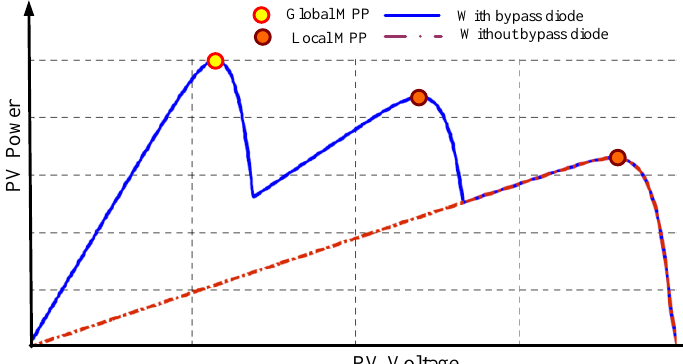
Figure 1. PV (photovoltaic) array power–voltage (P–V) characteristic under partial shading condition.